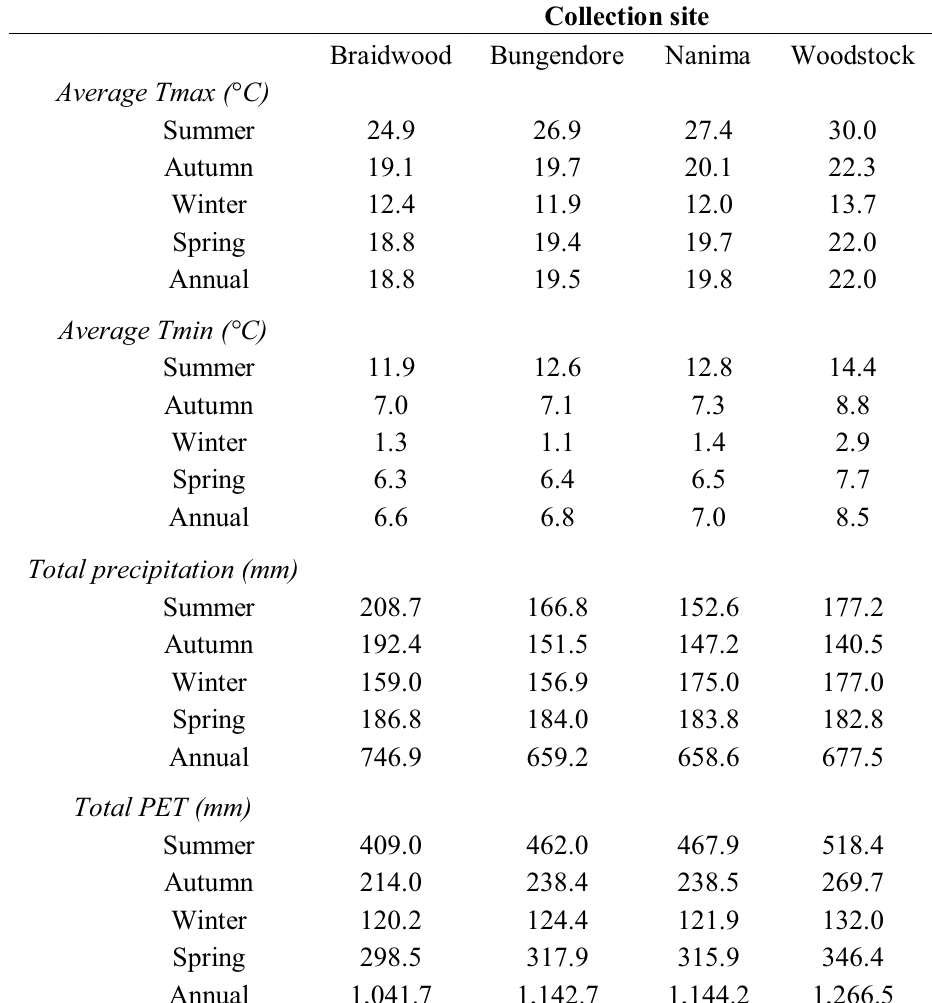
Table 1. Climate data (1910 (cid:177) 2009) for the four collection sites. Data were obtained from the SILO enhanced climatic data bank hosted by the Queensland Climate Change Centre of Excellence [63]. Tmax = maximum temperature; Tmin = minimum temperature; PET = potential